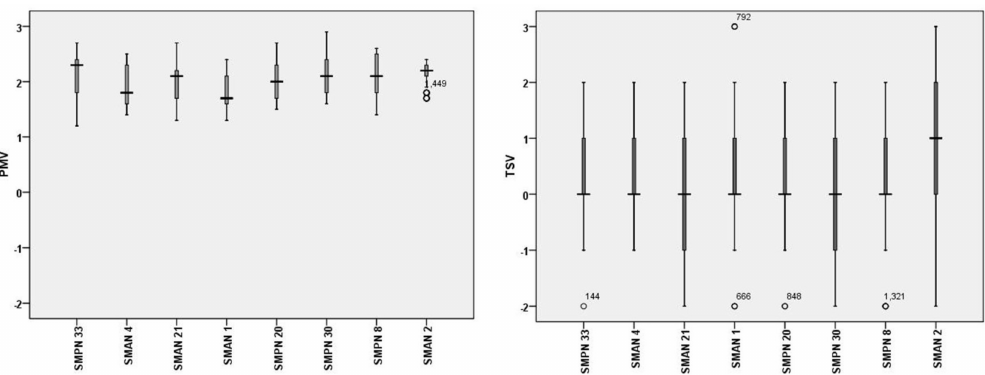
Figure 5. The comparison between the PMV and TSV (thermal sensation votes) of individual schools using